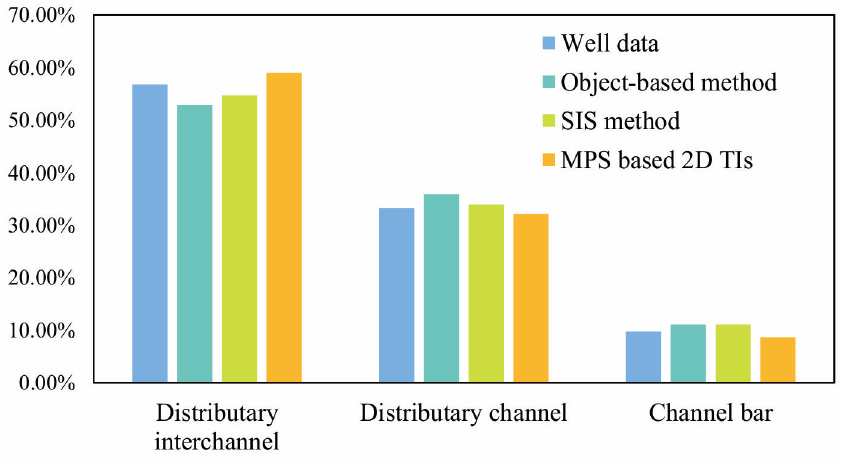
Figure 11. Facies model generated by three methods and sedimentary microfacies ratio of well data.